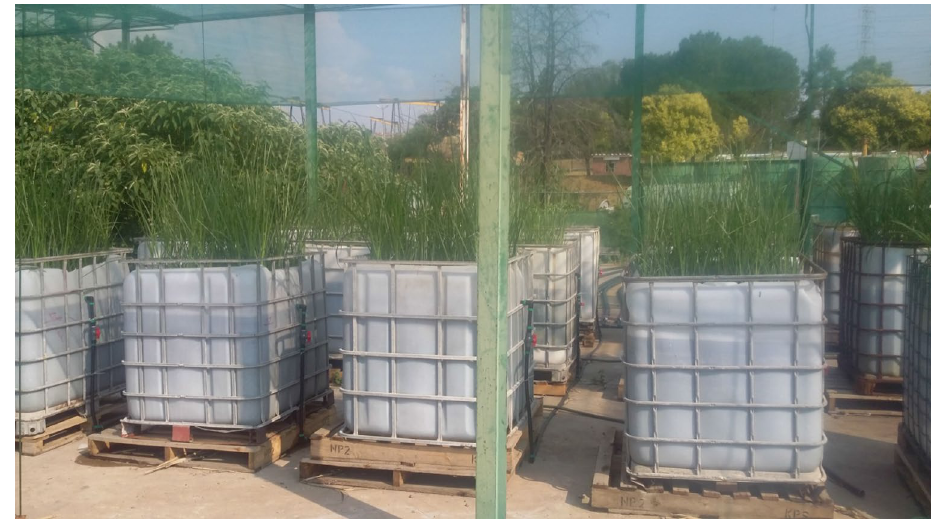
Fig. 1 Experimental setup showing pipe connections with V. zizanioides in VFCW